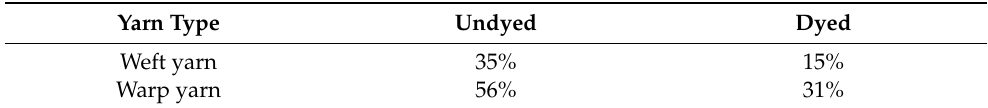
Table 4. Decrease in tensile strength in different directions of irradiated cotton yarns at 7.8 mJ/cm 2 laser fluency (modified from ref.